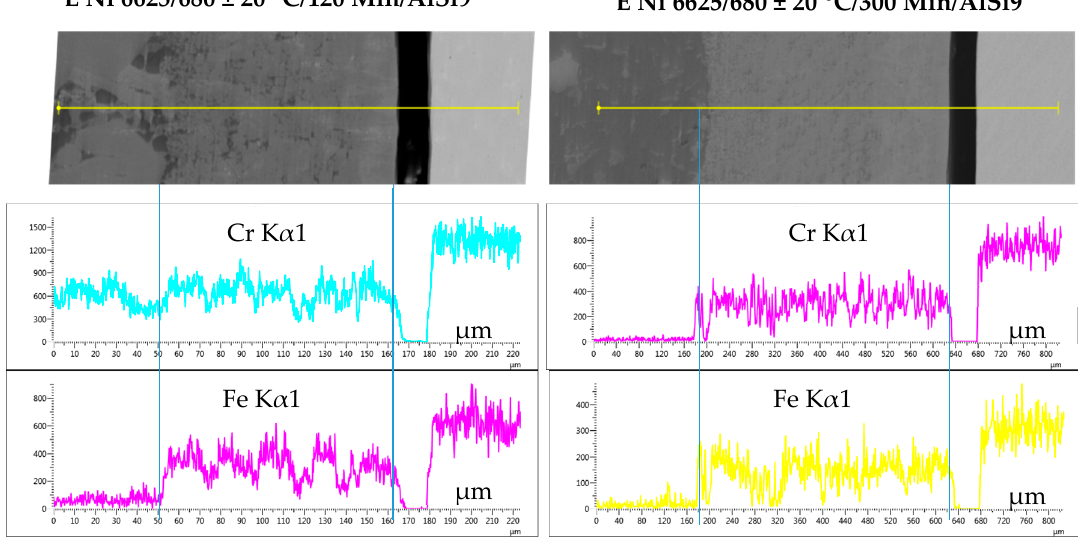
/ 680 ± 20 ◦ C / 300 min / AlSi9. EDX semi-quantitative microanalyses (mapping). Metals 2018 , 8 , x FOR PEER REVIEW 14 of 24 Figure 16. E Ni 6625/680 ± 20 °C/300 min/AlSi9. EDX semi-quantitative microanalyses (mapping). Figure 16. E Ni 6625